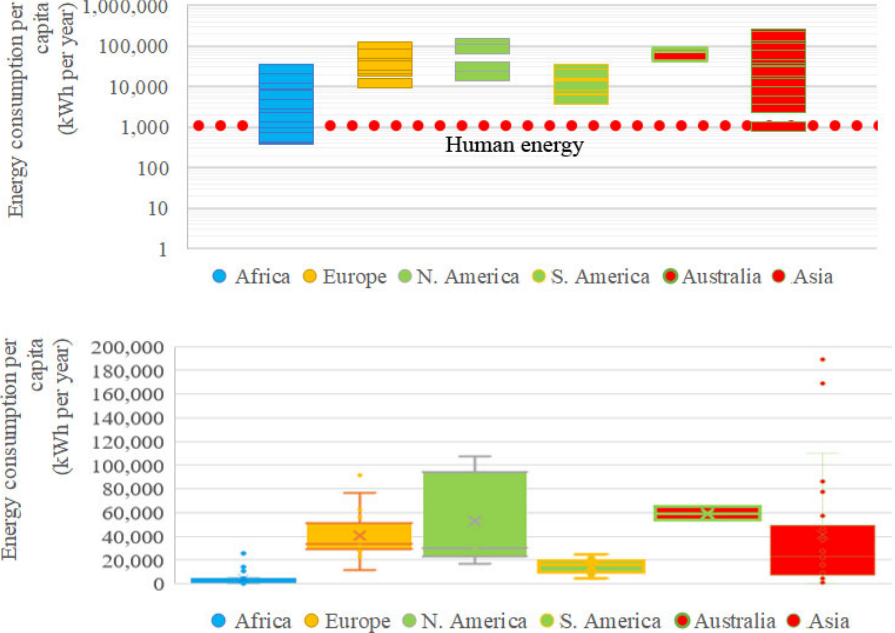
Figure 5. Annual energy consumption per capita in different countries (data from [106]). Top: plot in logarithmic scale indicating the human energy; Bottom: box plot.